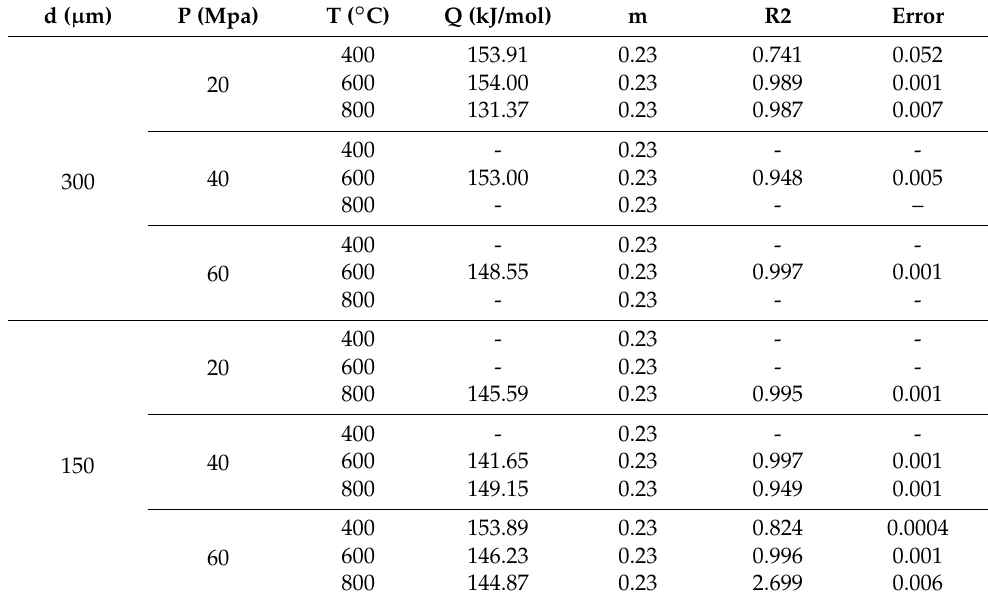
Table 1. Activation energy (Q) obtained from the regression analysis using Equation (1). Where d is the particle size; P and T are the pressure and temperature of the SPS process, respectively; m is the consolidation parameter; R2 is the correlation coefficient; and err is the minimum error. d ( µ